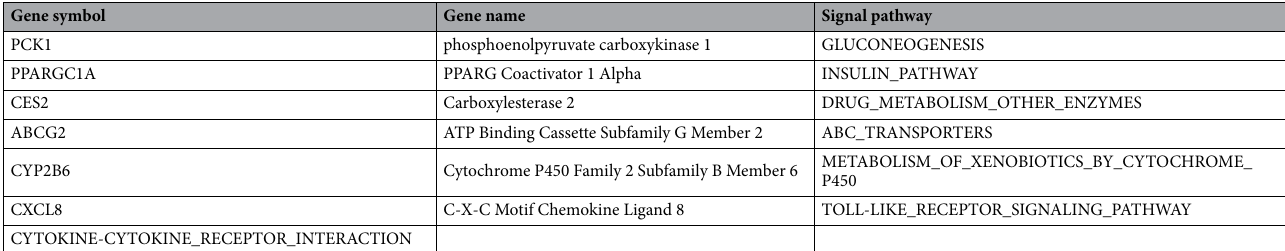
Table 3. Active genes and their corresponding signal pathways they participate in after PPI analysis with